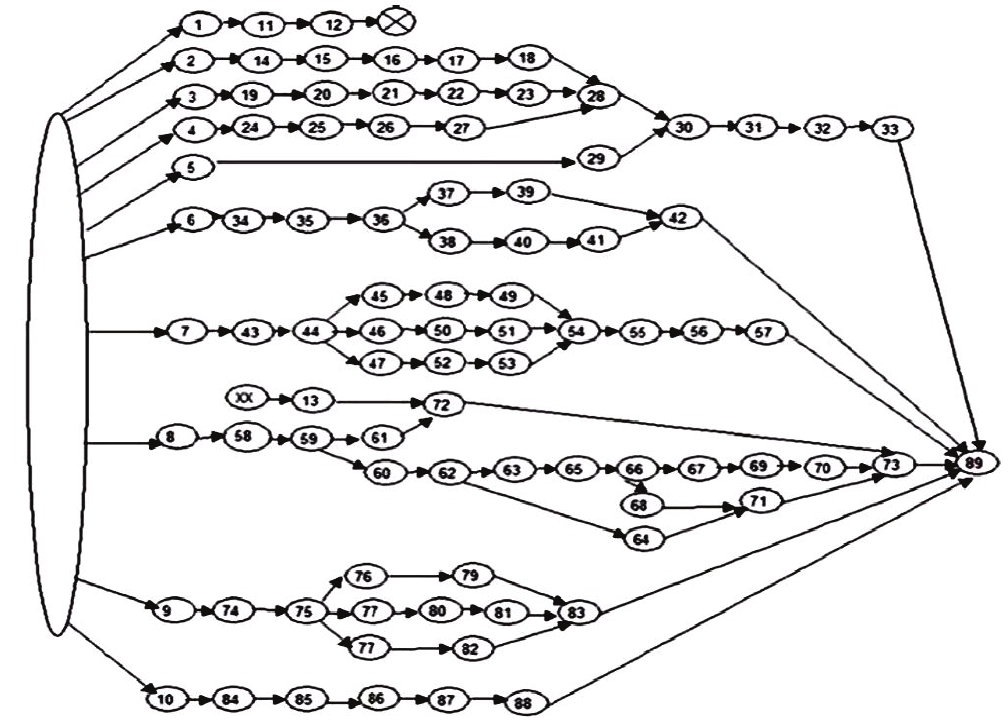
Fig. 9. Network of third case